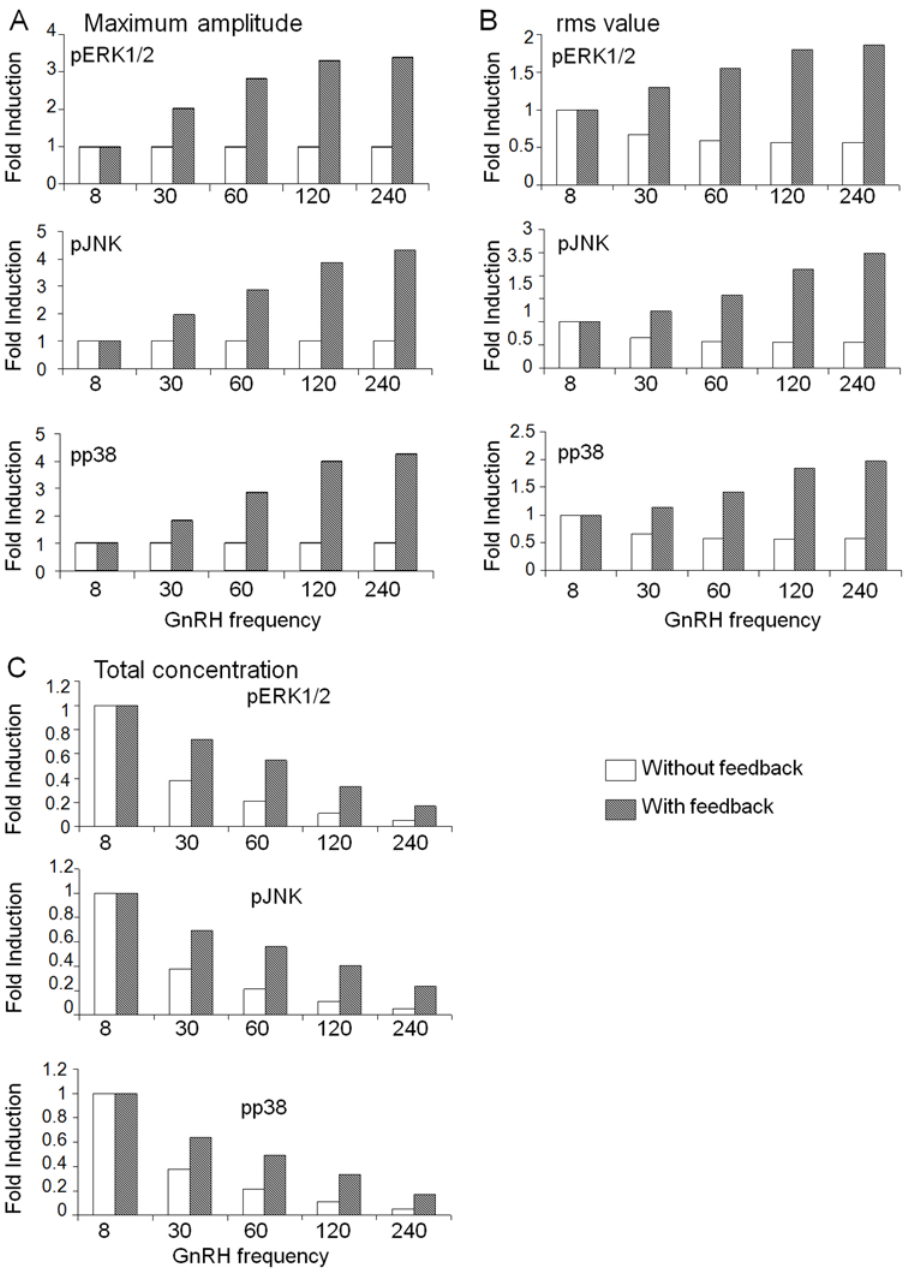
Figure 2. Analysis of MAPK activation for the basic model. The basic model with and without phosphatase feedback was simulated as in Figure 1. At the end of each simulation, (A) the maximum steady-state amplitudes, (B) the root mean square (rms) values, and (C) the total concentrations of each activated (p) MAPK were computed. These values were plotted as fold differences over corresponding values for 8 min pulse-